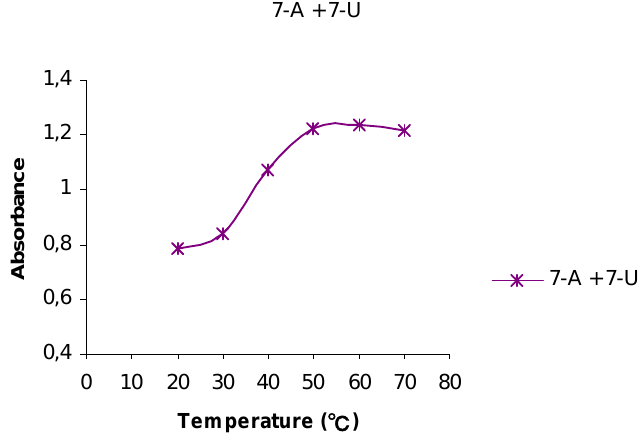
Figure 3 . The temperature dependency of the UV absorptions at 261 nm for a 1:1 and 7-U mixture of 7-A 6 8